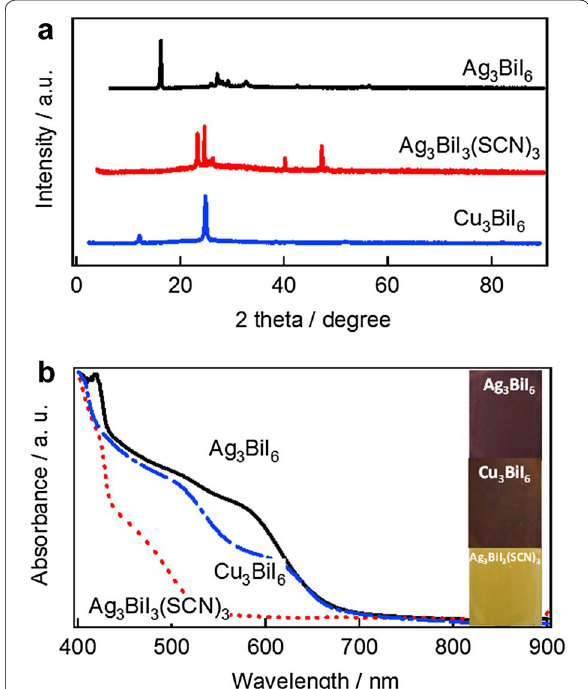
Fig. 6 XRD patterns ( a ) and UV–vis absorption spectra ( b ) of Ag 3 BiI 6 , Ag 3 BiI 3 (SCN) 3 and Cu 3 BiI 6 casted on the glass substrates. The insets were the pictures of Ag 3 BiI 6 , Ag 3 BiI 3 (SCN) 3 and Cu 3 BiI 6